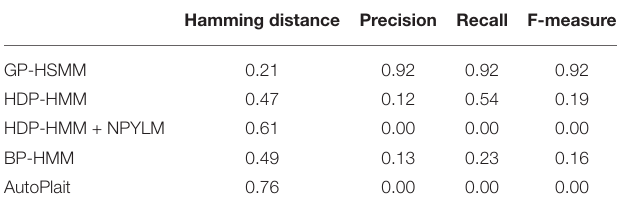
TABLE 2 | Segmentation accuracy of karate